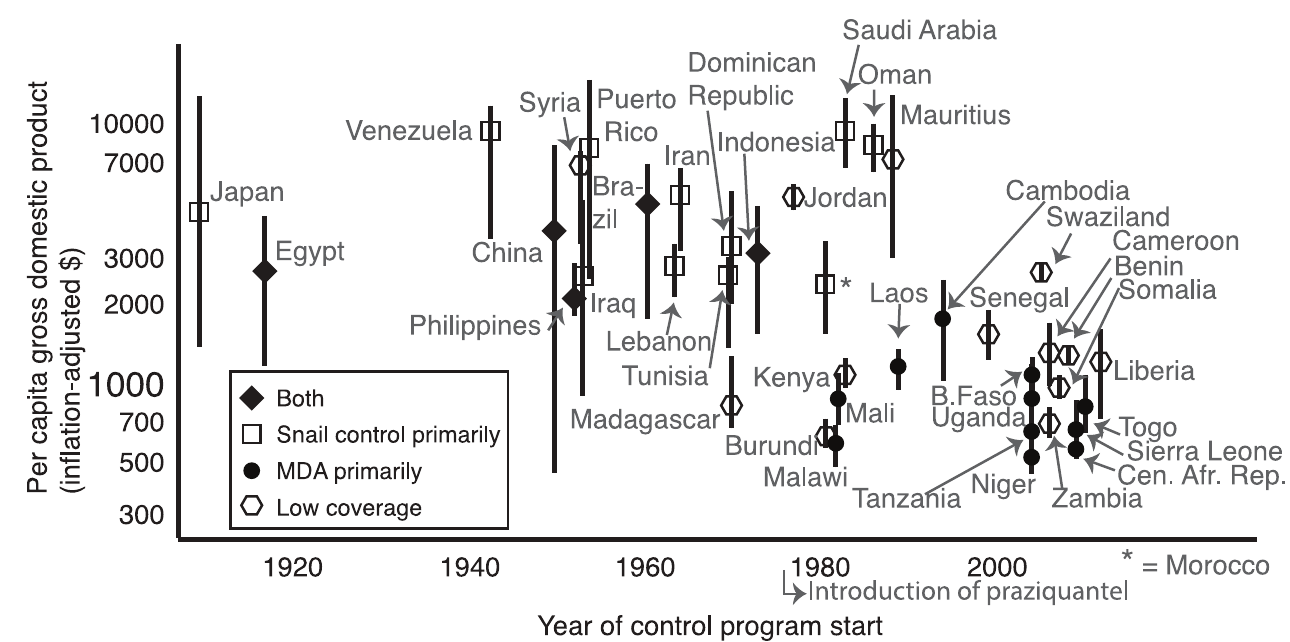
Fig 8. Per capita gross domestic product (GDP) as it relates to control strategy and control start date in each country. Points represent mean inflation-adjusted, per-capita GDP throughout the relevant time for which disease data were available, and bars represent the